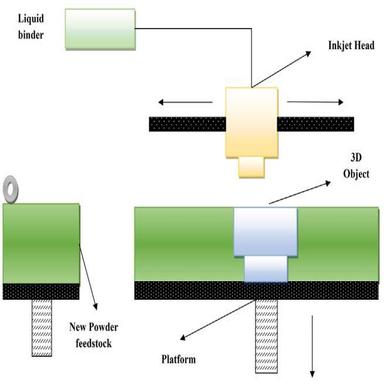
Schematic diagram of inkjet printing.